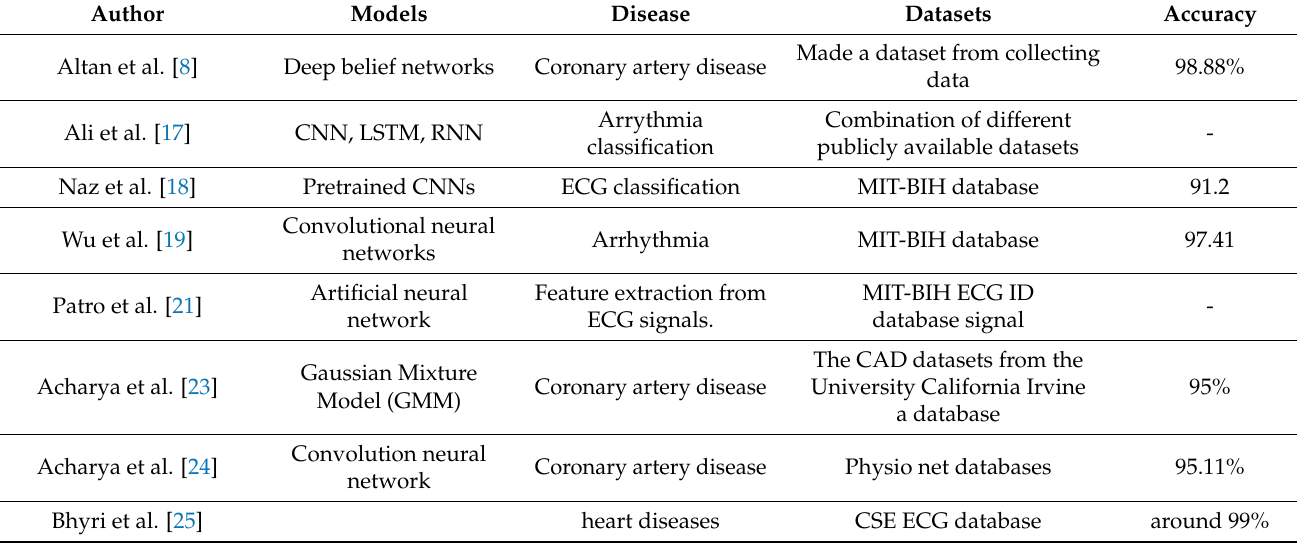
Table 1. Summary of literature